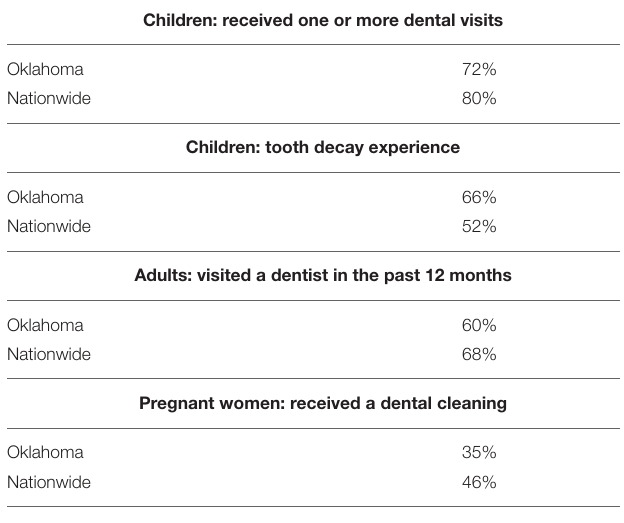
TABLE 1 | Oklaoma oral health statistics